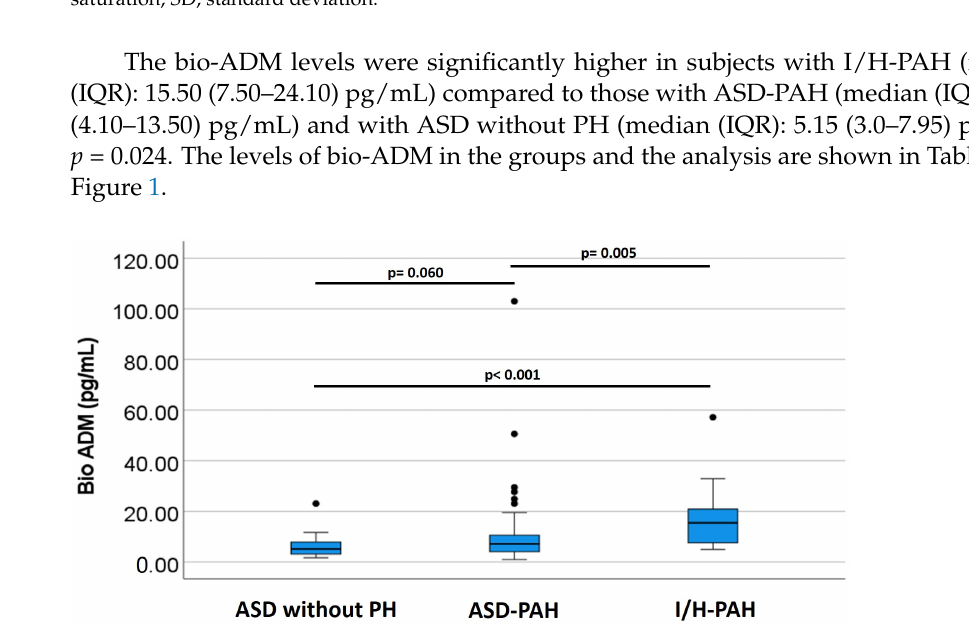
Table 3. Comparison of characteristics between all subjects who died (mortality (+) and those who survived (mortality ( − )).